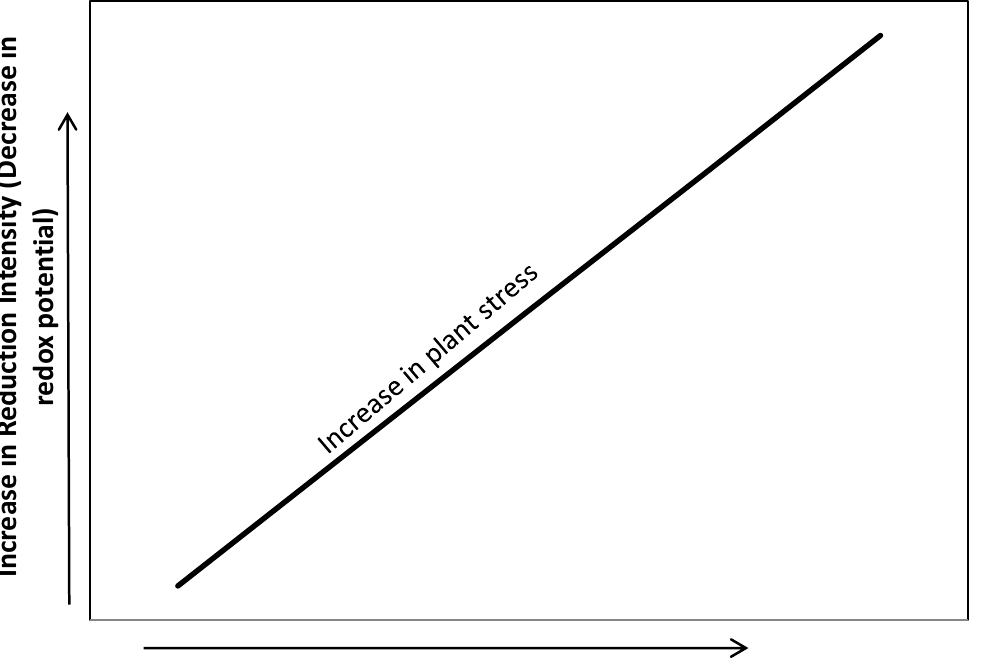
Figure 1. Oxidation-reduction potential in wetland soils: relationship of intensity and capacity of reduction in soil to wetland plant